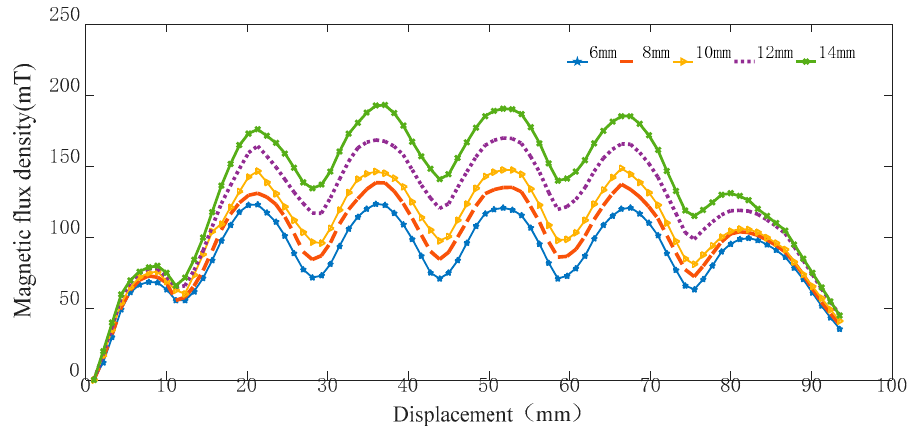
Figure 5. Effect of the magnetic ring radial thickness on the magnetic flux density.